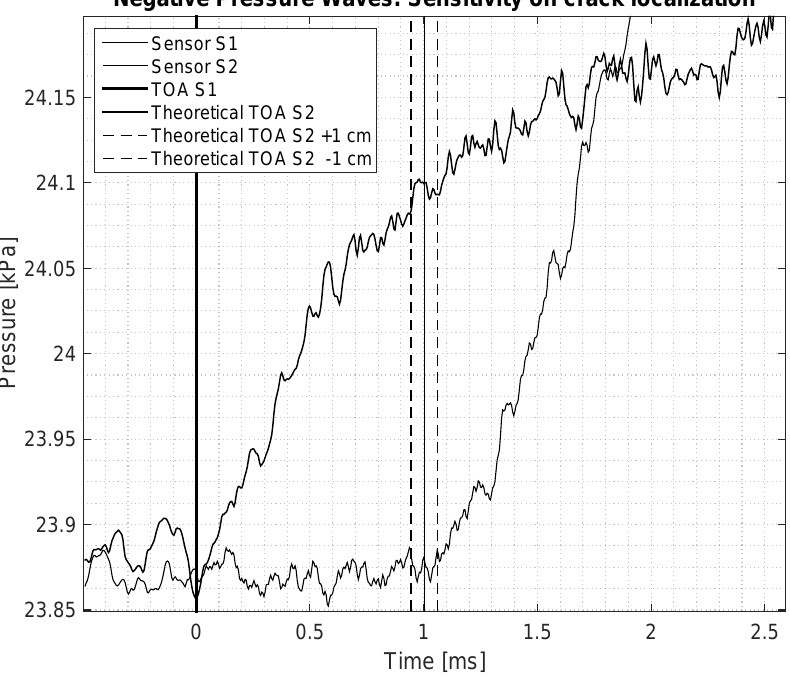
Figure 7. Sensitivity analysis for time-of-arrival point selection for crack